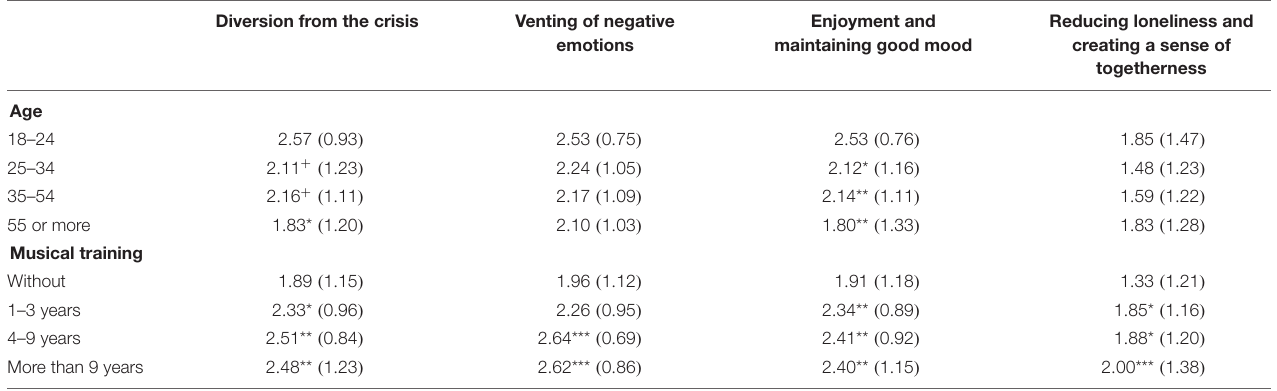
TABLE 3 | Music efficacy results for each goal by age and by musical training.